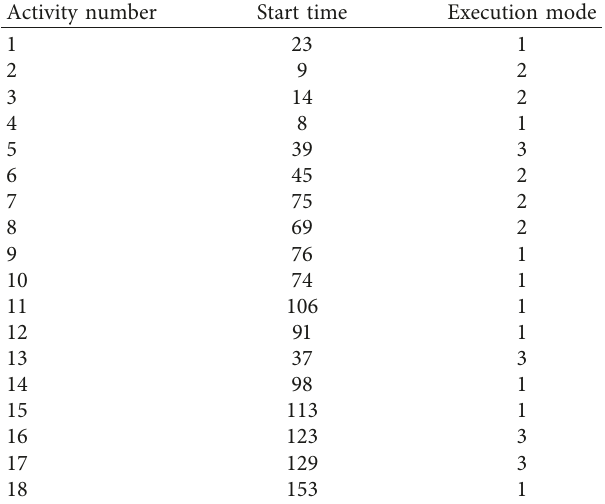
Table 5: Specific information of solution no.